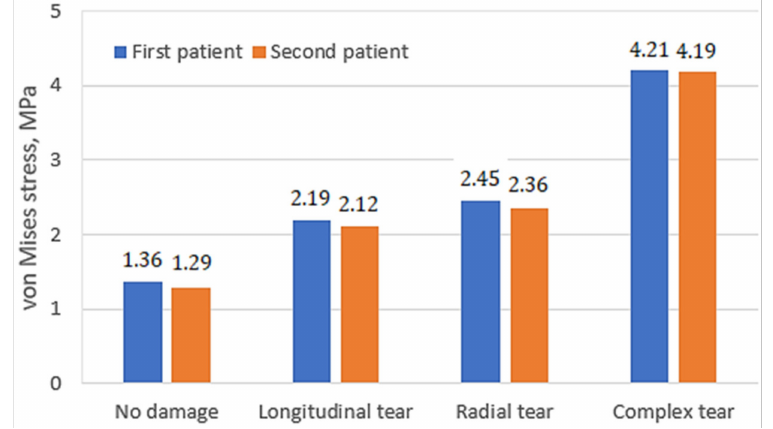
Figure 10. Maximum von Mises stress values on tibia